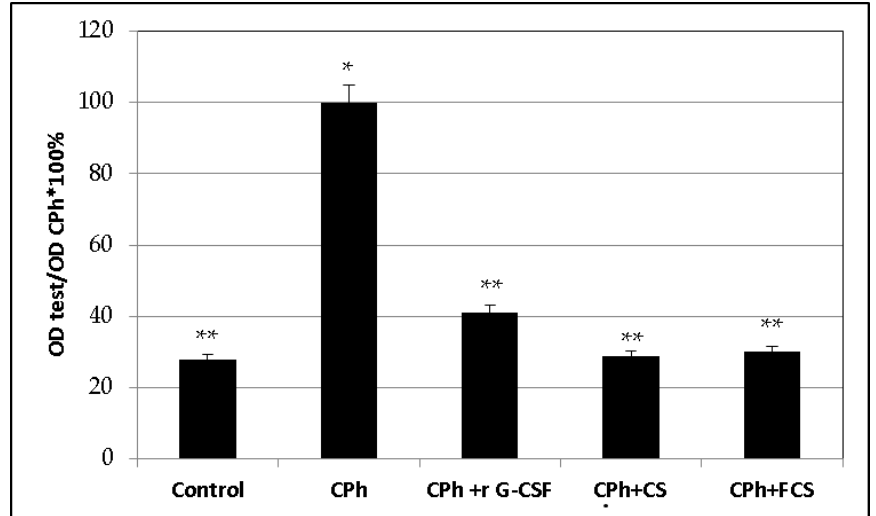
Figure 4. The level of IL-6 in blood of mice with CPh-induced immunosuppression after treatment with recombinant granulocyte colony-stimulating factor (r G-CSF), chondroitin sulfate ( CS ) and fucosylated chondroitin sulfate ( FCS ) (mean ± SD). * p < 0.05 vs. control, ** p < 0.05 vs. CPh.